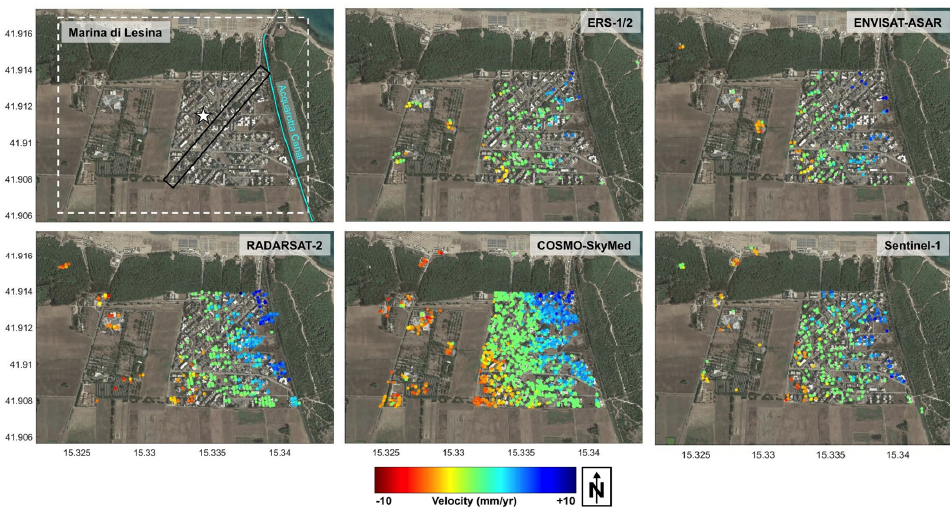
Figure 3. PS average LOS velocity maps for the Lesina Marina area: ERS, ENV, RSAT2, S1 and CSK. All the time series are acquired in ascending mode, right-looking configuration, with slightly different incidence angles (listed in Table 2). The white star in upper-left plot indicates the location of the reference PS point, common to all datasets. The black oblique rectangle is used to extract the PS velocity profiles shown in Figure 4.